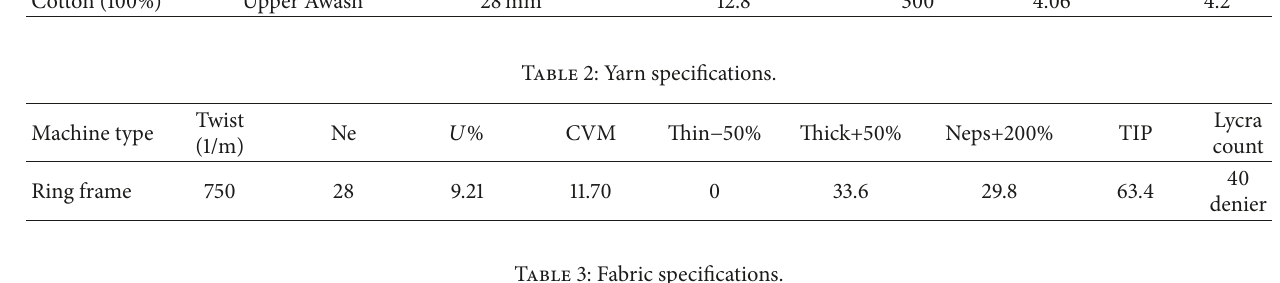
Table 3: Fabric specifications.